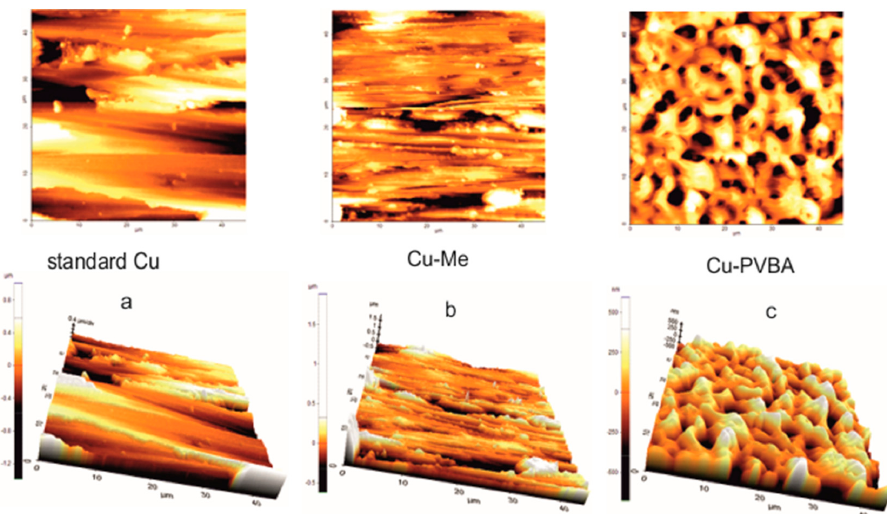
Figure 5. Atomic Force Microscopy (AFM) two-dimensional (2D) and three-dimensional (3D) images obtained for copper surface before corrosion: ( a ) Standard copper; ( b ) copper immersed in methanol (Cu-Me sample); ( c) copper immersed in methanol containing PVBA (Cu-PVBA sample).